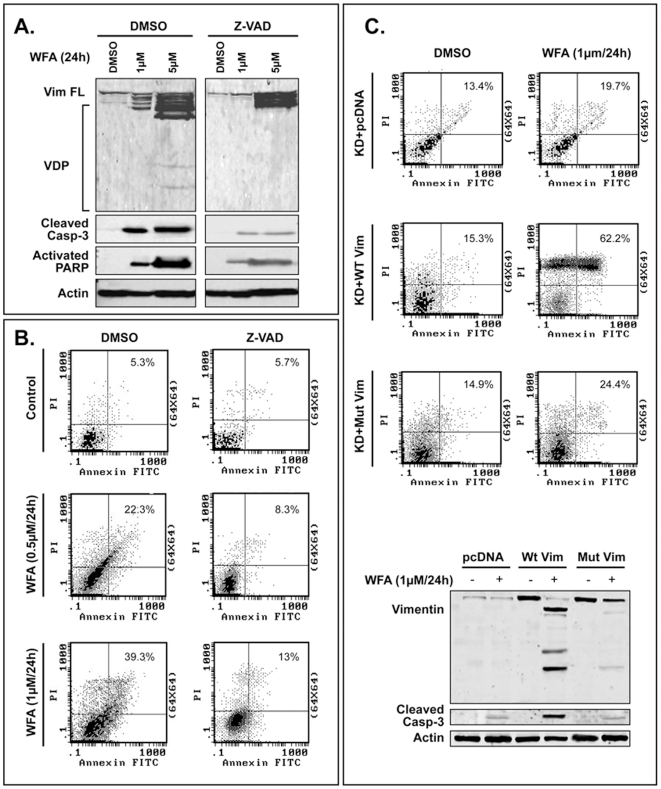
WFA-induced vimentin degradation is caspase-dependent.
A) Pretreatement (4 h) of SKLMS1 cells with Z-VAD (a pan-caspase inhibitor) results in decreased WFA-induced (24 h) vimentin degradation in conjunction with lower levels of both cleaved caspase-3 and activated PARP; B) Z-VAD (4 h) pretreatment significantly abrogates WFA-induced (24 h) apoptosis in SKLMS1 cells; C) Vimentin knocked down SKLMS1 cells were transfected to express either wild-type vimentin or vimentin mutated at caspase cleavage sites (D85N and D259N). WFA (1 µM/24 hr) induces marked apoptosis in wild-type vimentin transfected cells in which vimentin degradation and caspase-3 activation can be detected (WB). However, a significant decrease in WFA-induced apoptosis in cells expressing the mutated vimentin, is noticed as well as a decrease in both vimentin degradation and caspase-3 activation. (WT Vim =  wild type vimentin; Mut Vim  =  mutated vimentin; Vim FL  =  full length vimentin; VDP  =  vimentin degradation products)